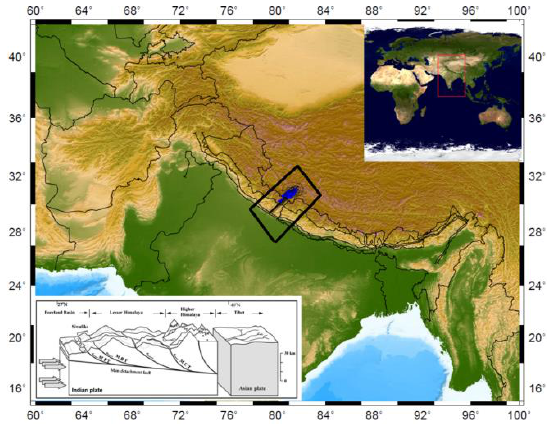
Figure 1. Study area in Garhwal-Kumaun Himalaya (Ponraj et al., 2010).